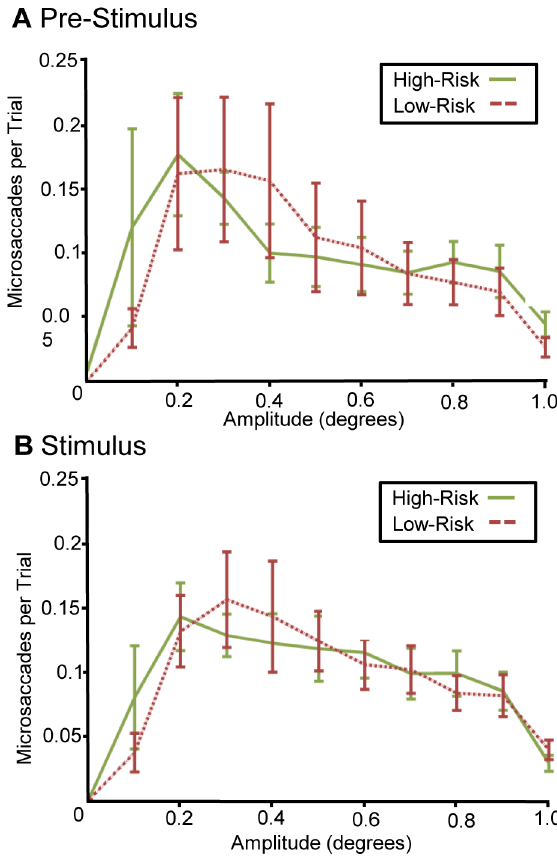
Figure 4. Microsaccades in high and low-risk groups. Partici- pants were designated as high-risk or low-risk based on initial UFOV scores. Pre-test microsaccade magnitude distributions were compared for these groups and no difference was observed in microsaccade magnitude distribution for both pre-stimulus data (A) and data collected during the stimulus (B). Error bars shown are standard error of the mean.